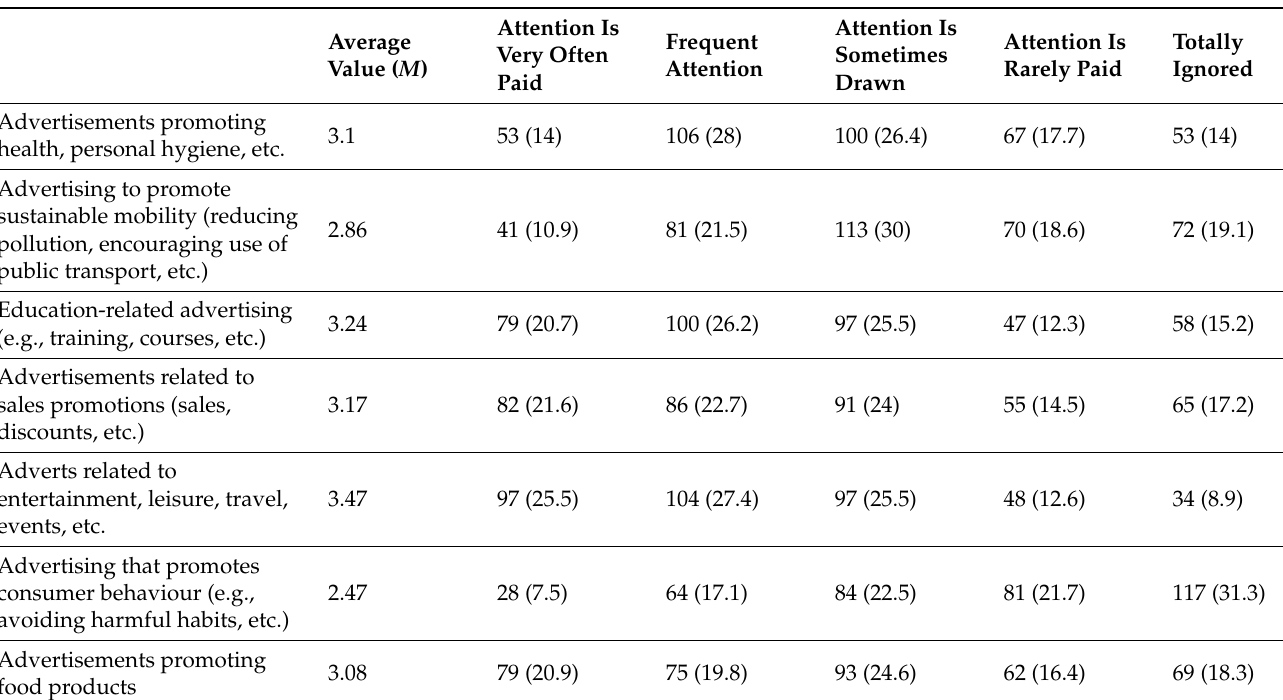
Attention Is Rarely Paid